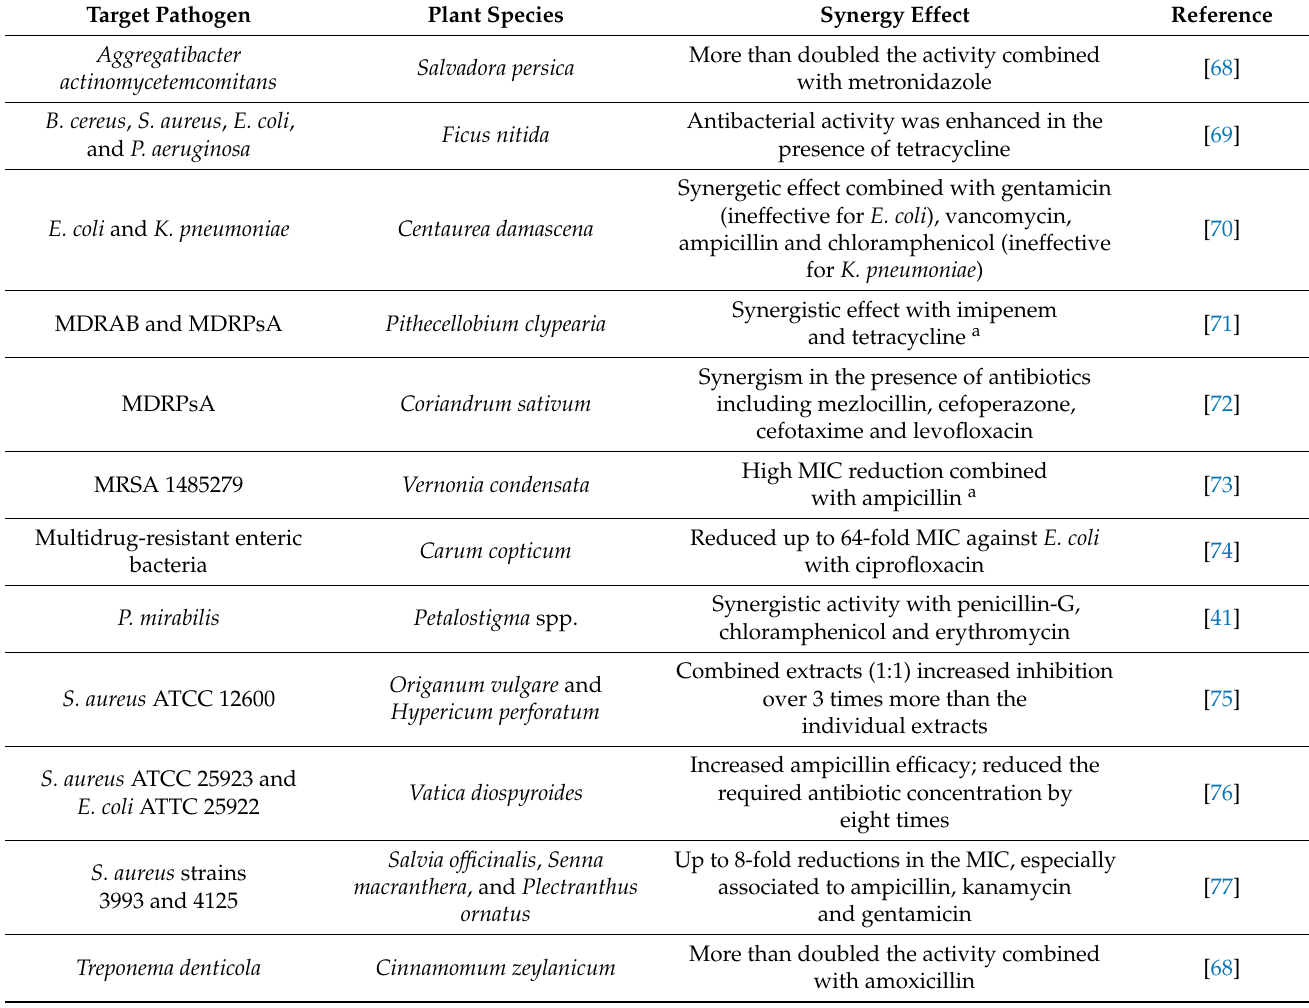
Table 2. Synergy effect of plant species with antibiotics towards bacterial